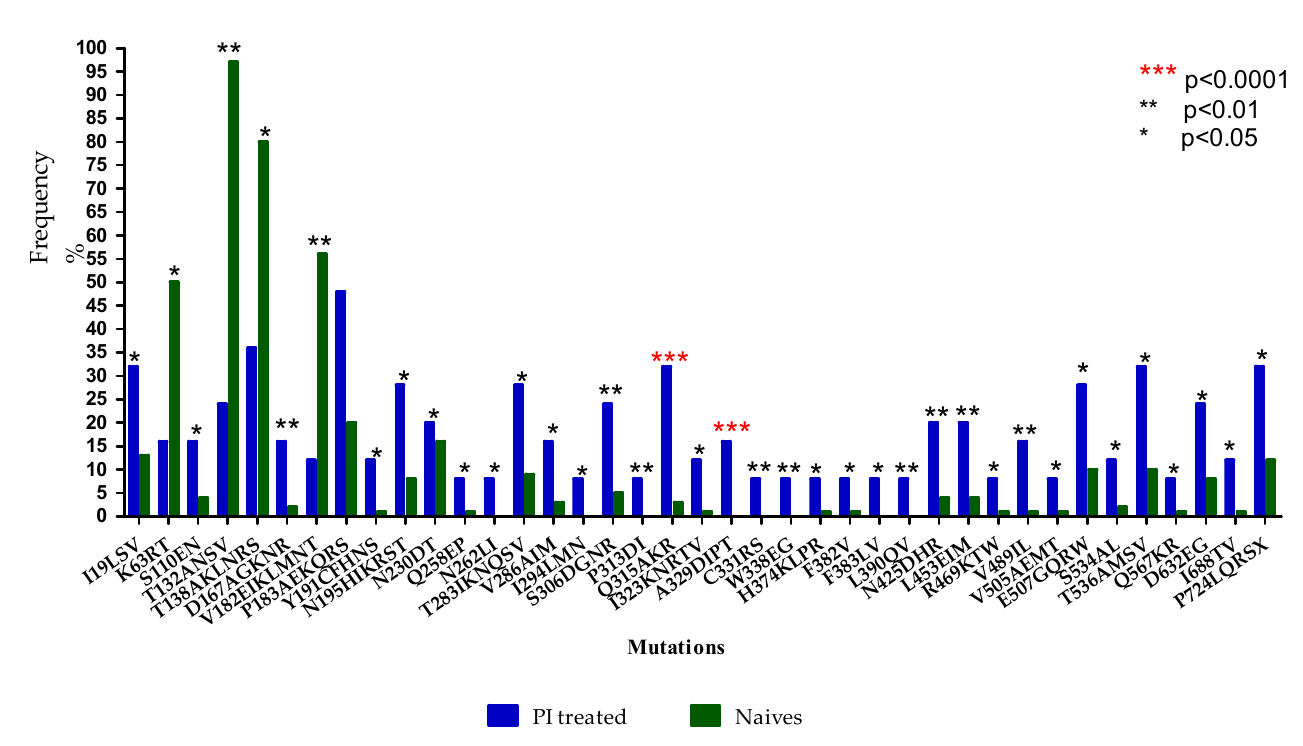
Microbiol. Res. 2021 , 12, FOR PEER REVIEW Figure 1. Frequency (%) of Env mutations in ART-naïve versus LPV/r-treated subtype C isolates. Asterisks (*): *** represents Figure 1. Frequency (%) of Env mutations in ART ‐ naïve versus LPV/r ‐ treated subtype C isolates. Asterisks (*): *** p < 0.0001, ** represents p < 0.01, and * represents p < 0.05. represents p < 0.0001, ** represents p < 0.01, and * represents p < 0.05.